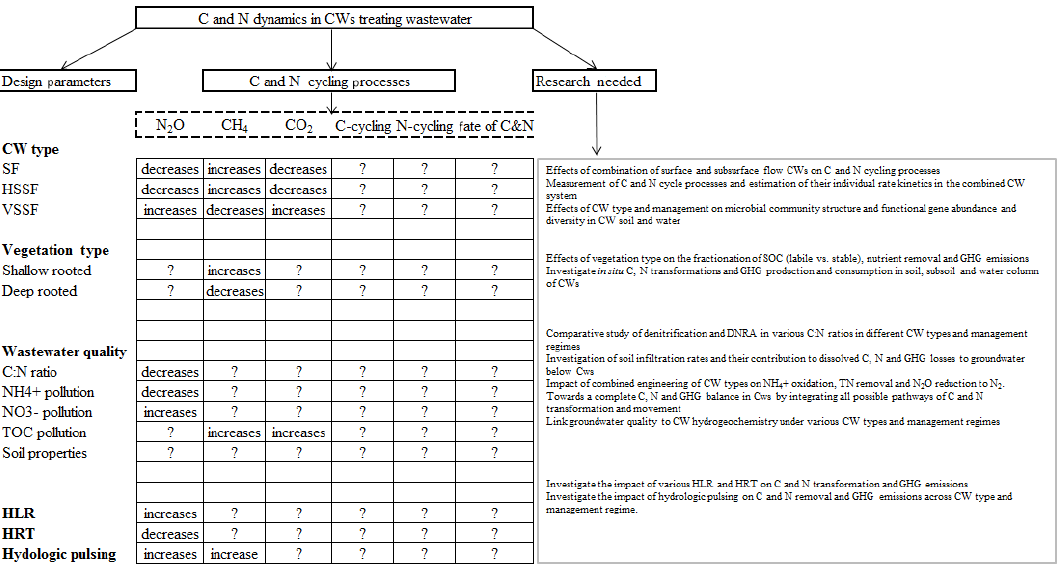
Figure 1. Conceptual model showing the current state of knowledge of C and N dynamics in constructed wetlands treating wastewater and the specific experimental work that needs to be undertaken in the future; SF – surface flow; HSSF – horizontal subsurface flow; VSSF – vertical subsurface flow; HLR – hydraulic loading rate; HTR – hydraulic retention time; ? – not known or very little